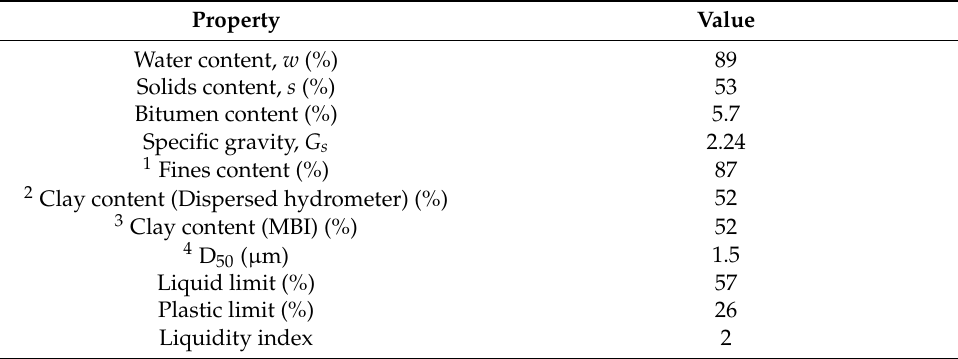
Table 1. Geotechnical properties of the centrifuged